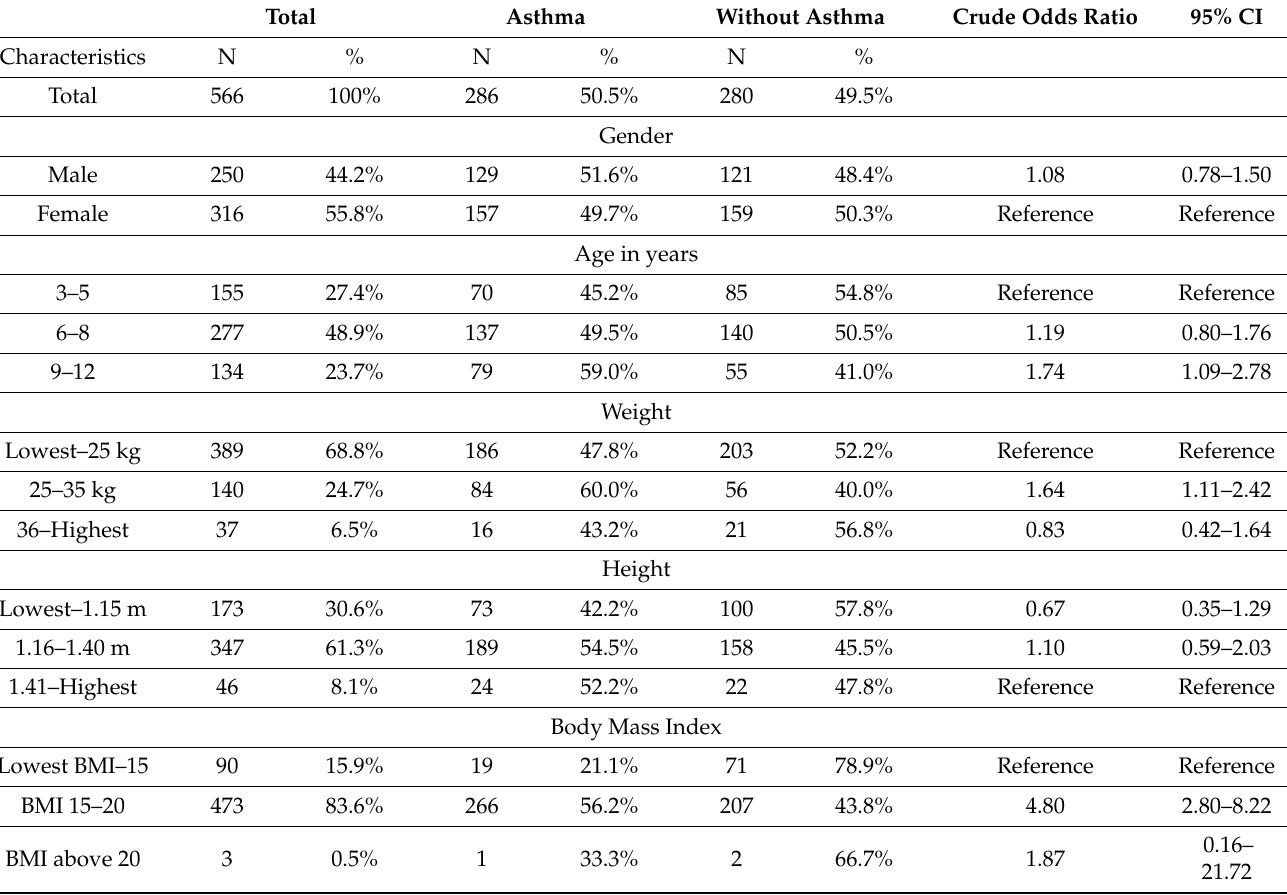
Table 2. Distribution and Crude Odds Ratios of Participants by Socio-demographic